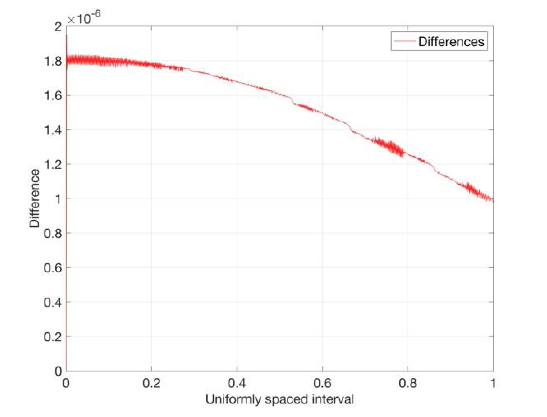
Figure 4. Absolute Errors of Equation